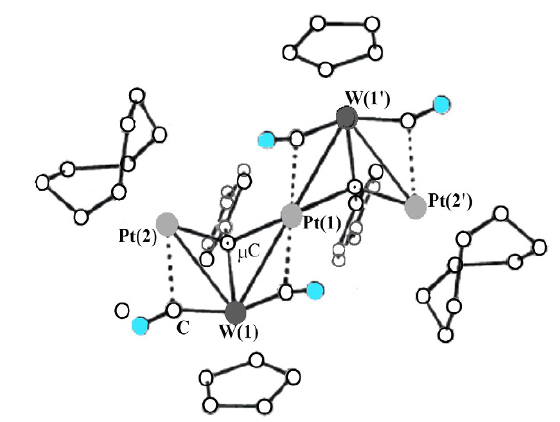
Figure 2. Structure of {{( η 4 -cod) PtW(CO)